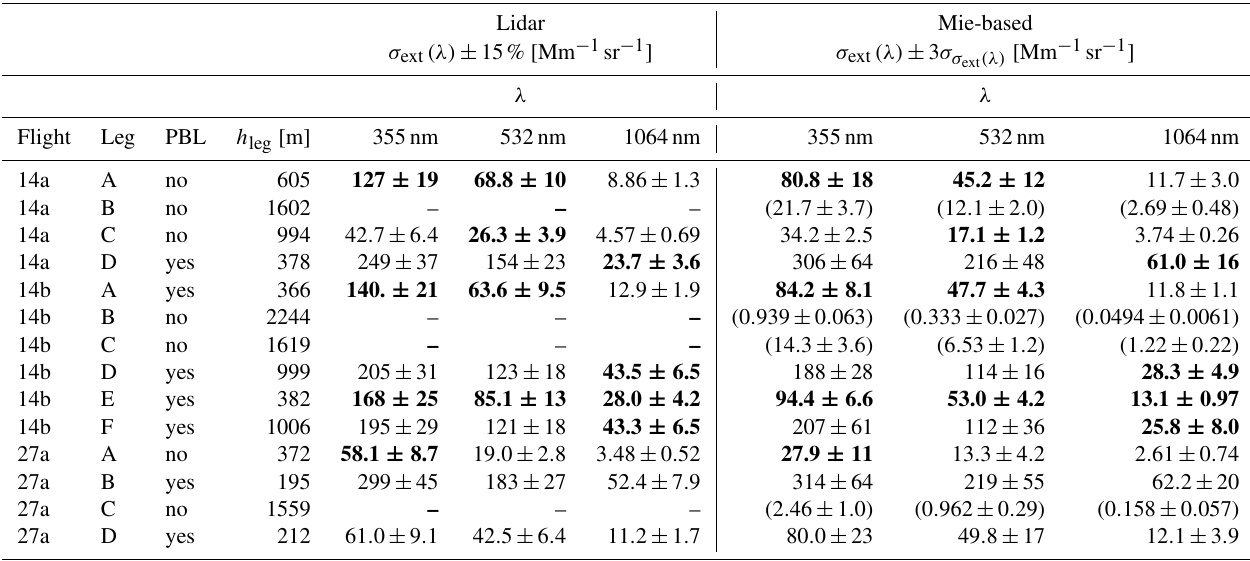
Table B2. Table shows the aerosol particle light extinction coefficient ( σ ext ) derived with the lidar for the wavelengths 355, 532, and 1064nm for the mean height of each investigated leg. Also, the aerosol particle light extinction coefficient converted from the airborne in situ aerosol measurements is printed for the respective lidar wavelength and horizontal leg. Additionally, it is shown whether the horizontal flight leg was conducted within or above the PBL. Values written in bold represent a disagreement between lidar and model, while normal script is an agreement. Brackets around the values indicate no lidar measurements